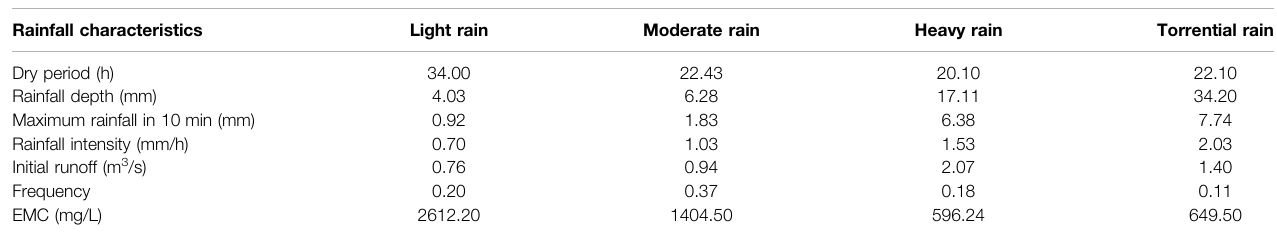
TABLE 2 | Effects of typical rainfall characteristics on EMC. Rainfall